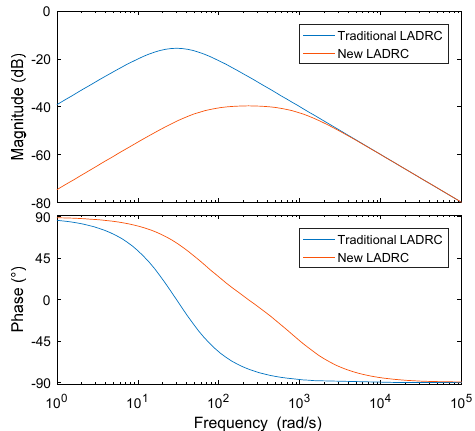
Figure 9. Frequency-doman characteristic curves of the observed noise.